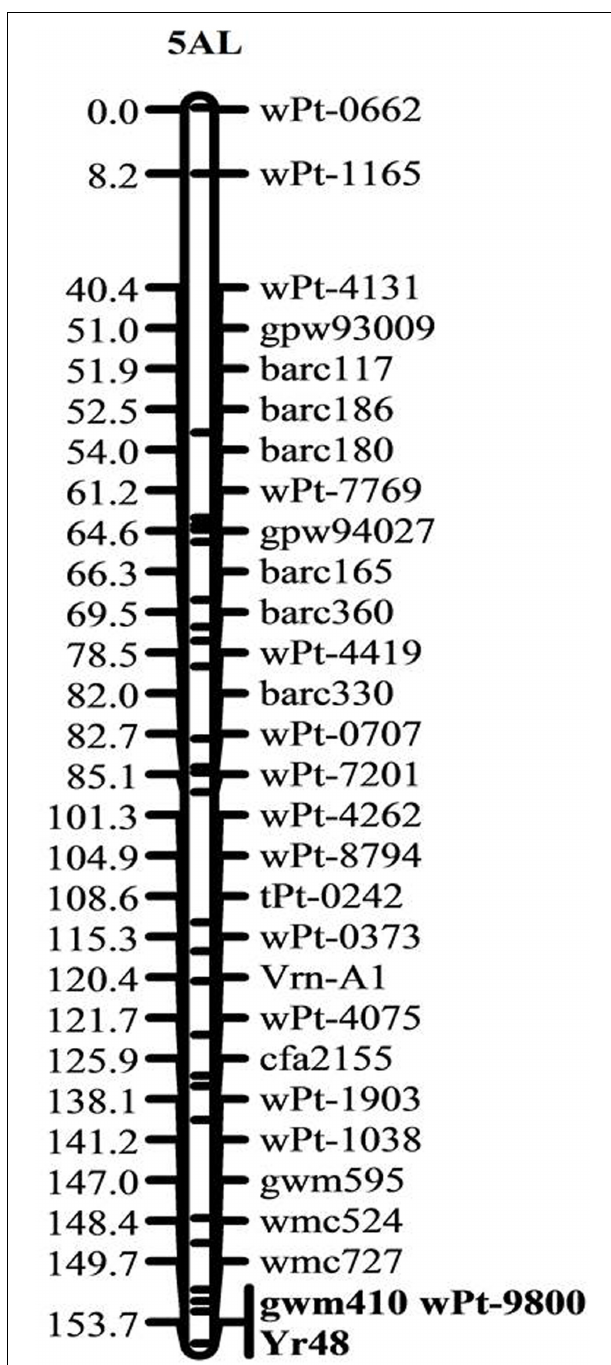
FIGURE 1 | Genetic linkage map of chromosome 5A showing the location of the all-stage resistance gene Yr48 . Locus names and corresponding locations on the genetic map are indicated on the right side. Map distances in cM are shown on the left side. Markers co-segregating with Yr48 are given in bold.